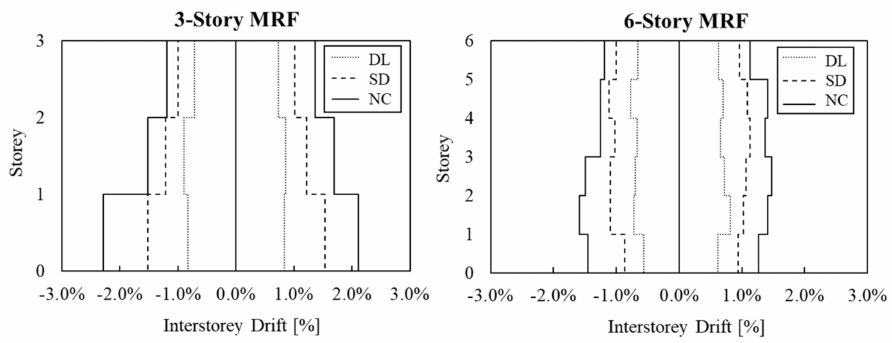
Figure 5. Results from IDAs: interstorey drift for examined MRFs.